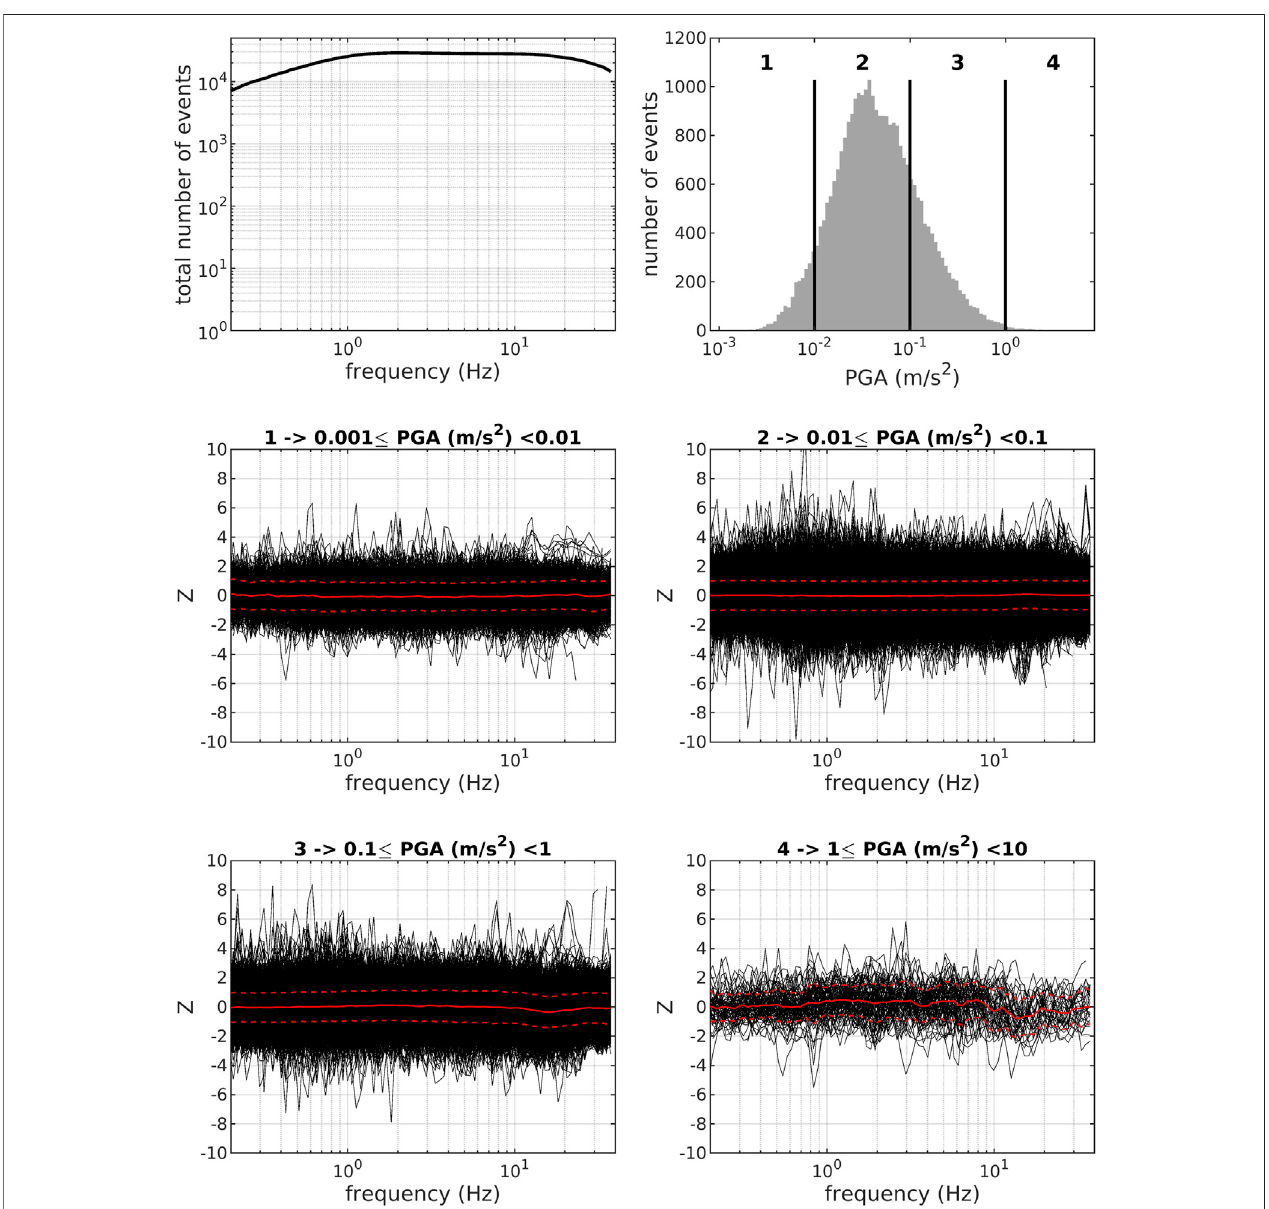
FIGURE10 | Top-left panel: Total number ofnormalized ampli fi cation functions obtain from 3 Swiss SSR distribution and 60SBSRJapanese distribution and asa function of frequency. Top right: Histogram of the peak ground acceleration (PGA) distribution. From middle left to bottom-right panel: normalized ampli fi cation function for four PGA bins and as a function of frequency. The mean and mean plus/minus standard deviation are represented with solid red lines and dotted red lines respectively.